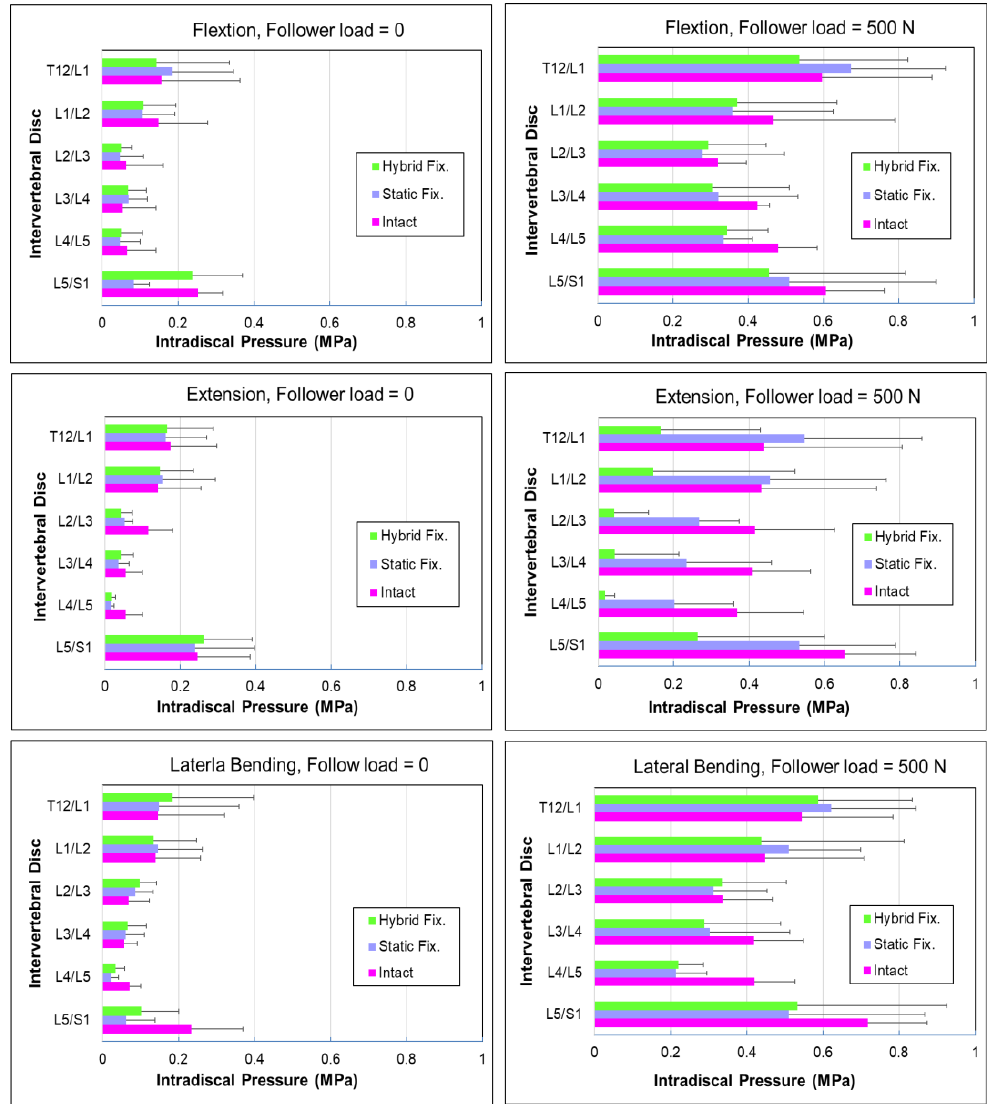
Figure 5. Values of intradiscal pressure (IDP) for each intervertebral disc segment.